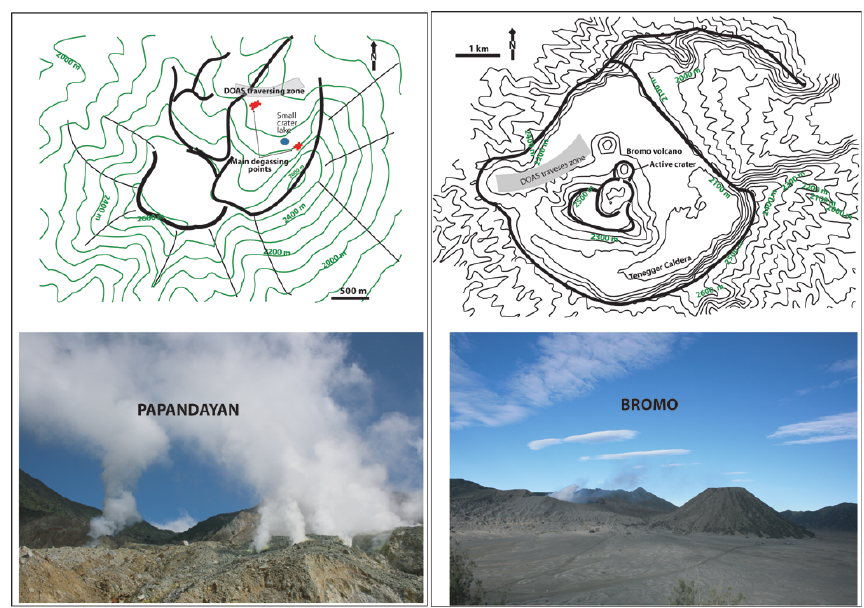
Fig. 2. Maps of the Papandayan summit and the Bromo caldera. The DOAS traverse zones are shaded in gray. The main degassing points are shown: fumarole zones on Papandayan and the active crater on Bromo. Pictures provide a synoptic view of degassing during the field